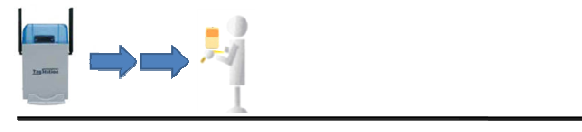
Figure 6. Experimental